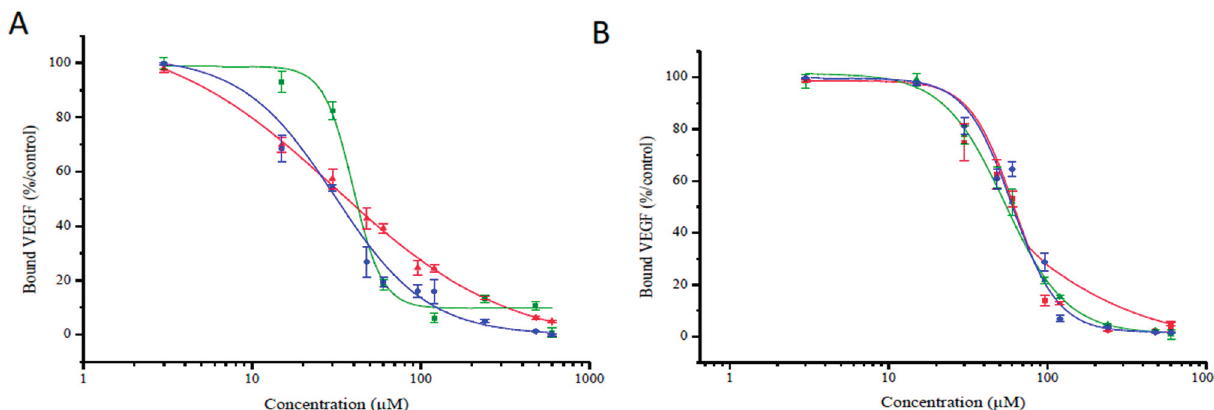
Figure 5. Binding of biotinylated VEGF (vascular endothelial growth) to NRP-1 (neuropilin-1 receptor) in the presence of 2 µg/mL heparin was evaluated in the absence (negative control), or presence, of novel TPC–peptide conjugates to recombinant NRP-1 protein (data points show the mean ± S.D., n = 3).